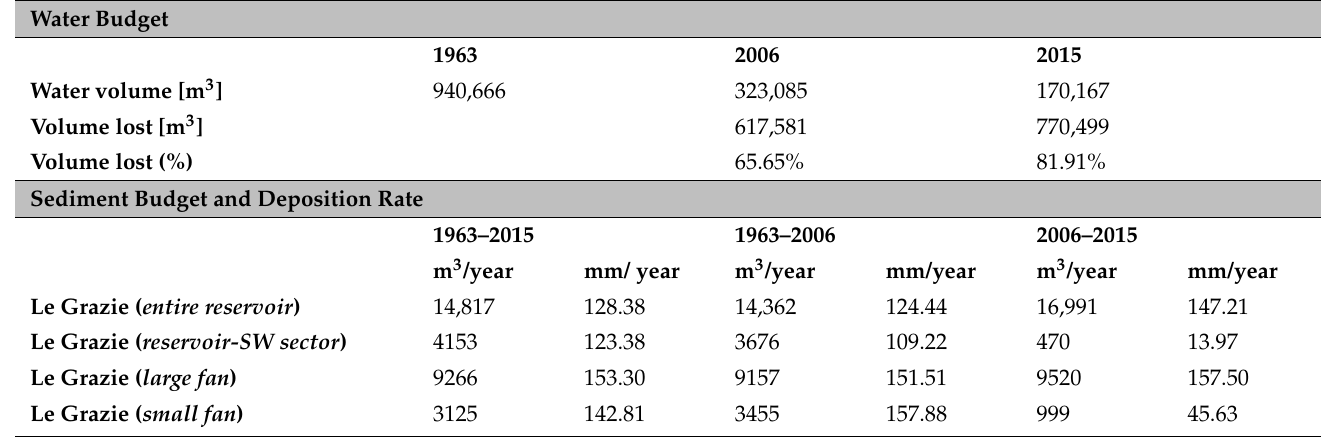
Figure 6. Water depth (depth to the top of the sediment infill) reconstruction for Le Grazie reservoir in the years 1963, 2006, and 2015. Table 4. Storage capacity and filling rate of Le Grazie reservoir in the years 1963, 2006, and